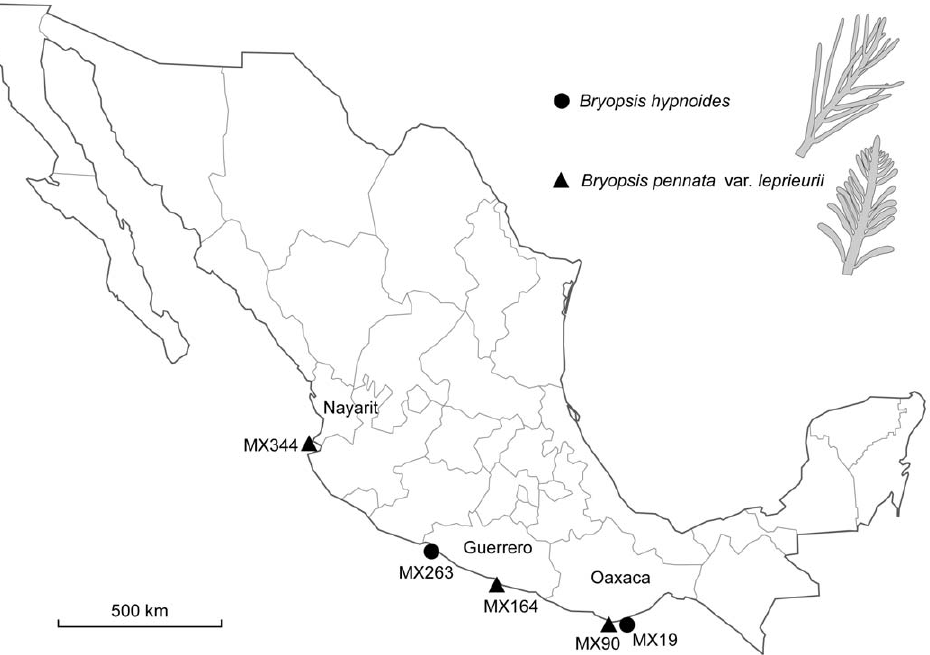
N ) and Bryopsis pennata var. leprieurii ( m ) samples were